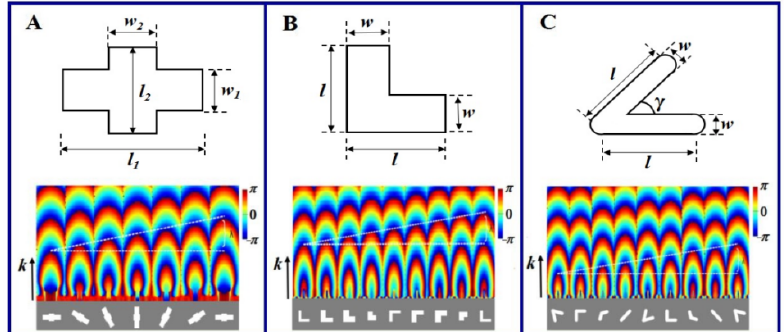
Figure 1. ( A ) Rotated cross nanoholes, ( B ) eight L-shaped nanoholes and ( C ) eight V-shaped Figure 1. ( A ): Rotated cross nanoholes, ( B ): eight L-shaped nanoholes and ( C ): eight nanoholes and their transmission phase V-shaped nanoholes and their transmission phase distributions.